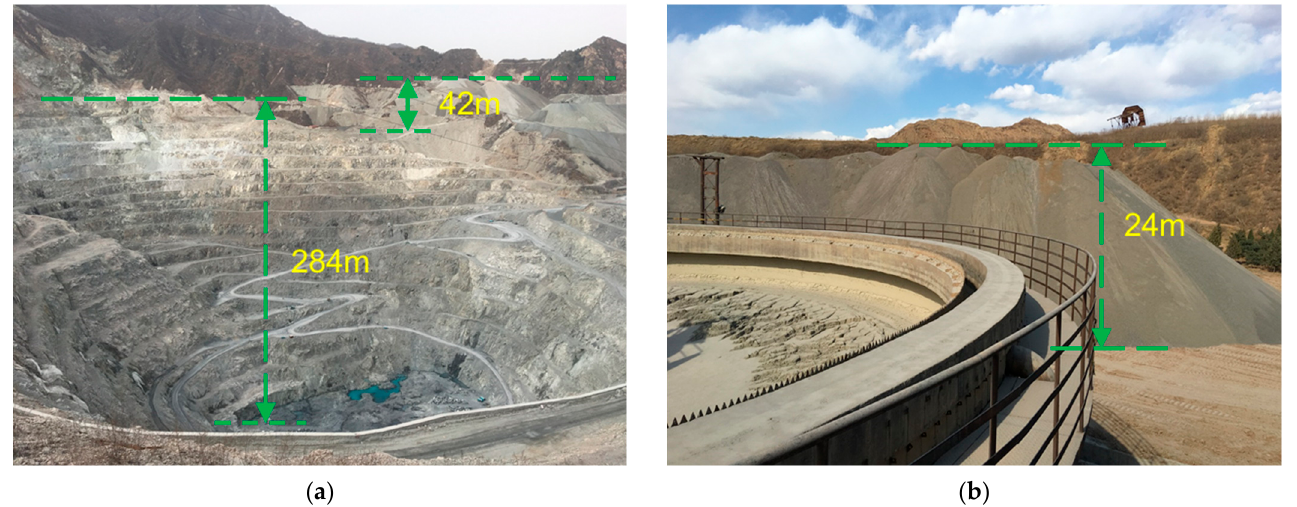
Figure 1. Photos of iron tailings stacking dam in Hebei, China: ( a ) mining and tailings site; ( b ) tailings site.